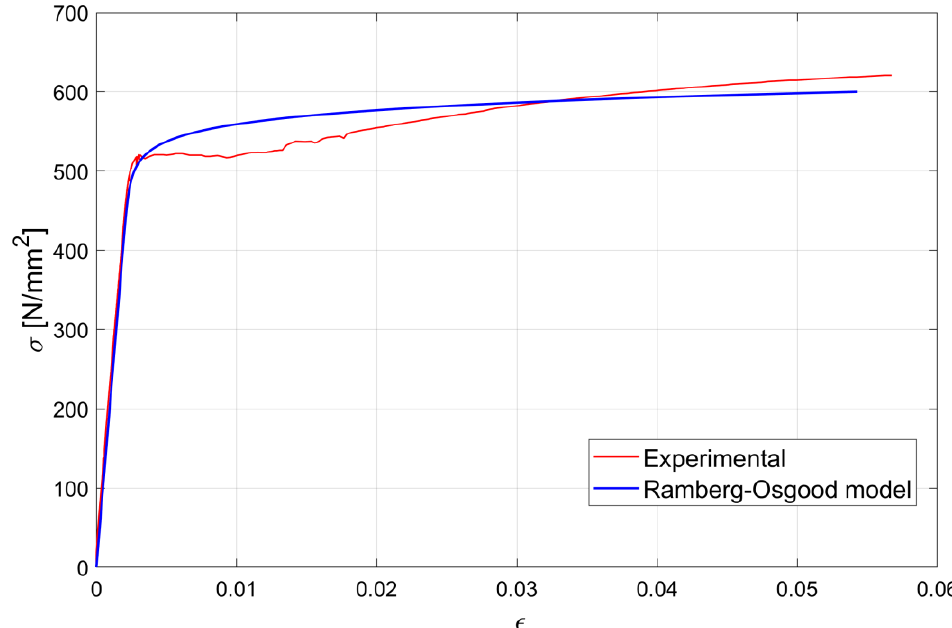
Figure 6. Experimental stress–strain diagram for a φ 16 steel rebar used in the test campaign.